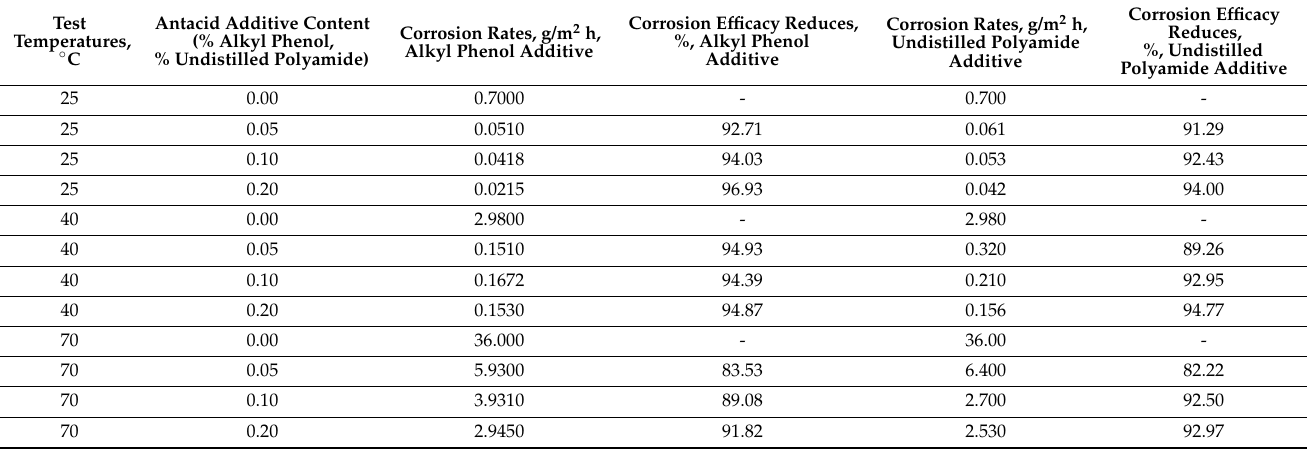
Table 6. Corrosion rate determined on samples collected from the material of the distillation column (OL37), introduced in a bath with HCl in proportion of 10%.